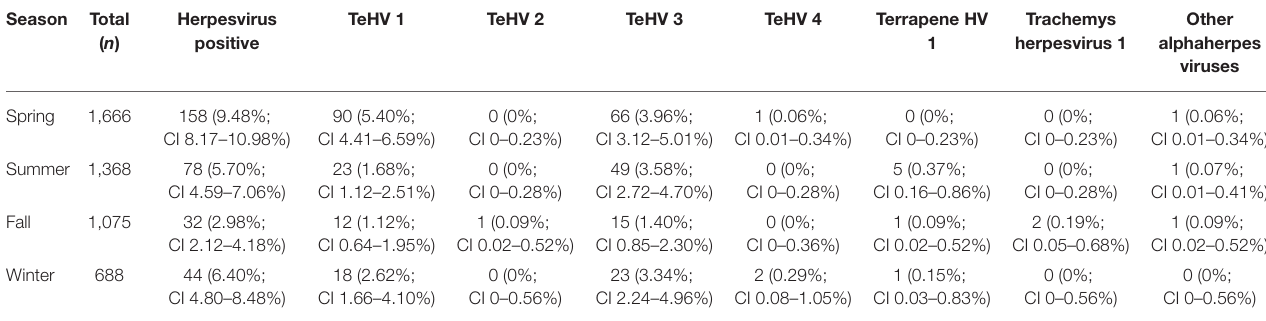
TABLE 3 | Herpesvirus positivity rate according to virus strains and season of